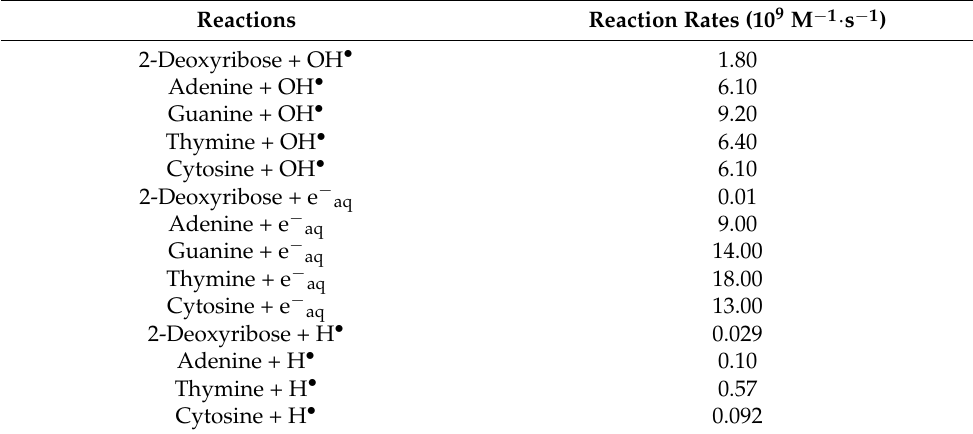
Table 2. List of reactions considered in the simulation and their associated reaction rates.